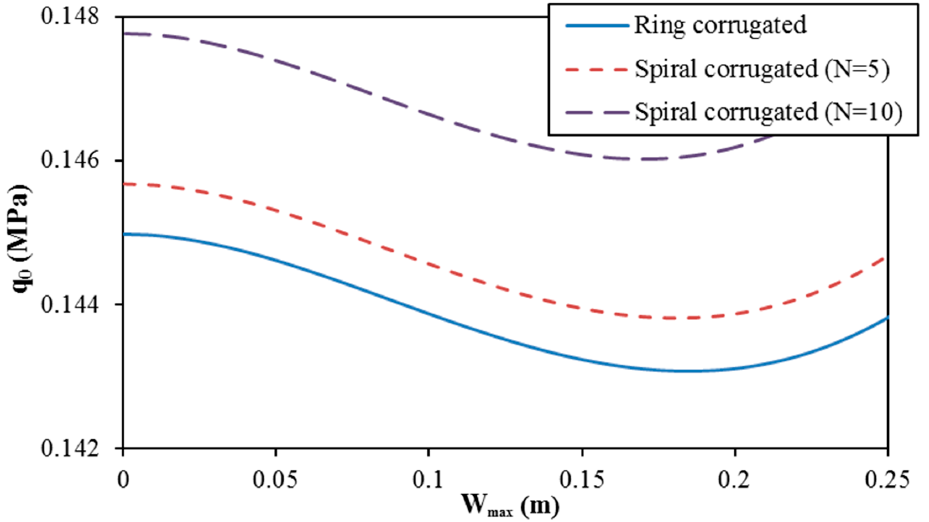
Figure 5. Postbuckling curves of ring and spiral corrugated UD-CNTRC cylindrical shells (round corrugation, V ∗ CNT = 0.12, r = 0.005m, d 0.002m).